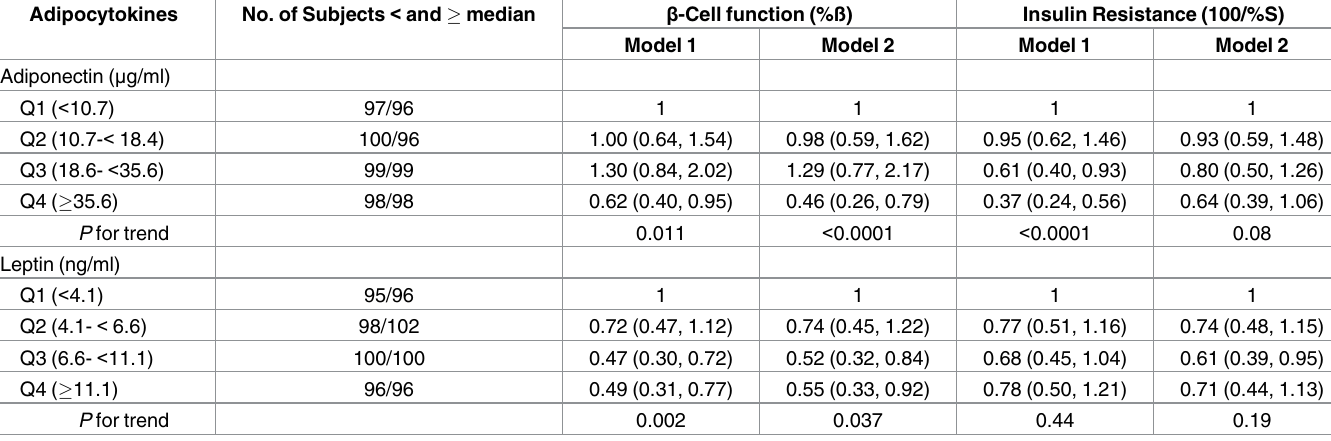
Table 4. Odds ratios (OR) and 95% confidence intervals (CI) for the higher levels ( (cid:21) median) of the HOMA parameters in relation to serum concen- trations of adipocytokines in a rural Chinese population in Ningxia, 2008–2012.